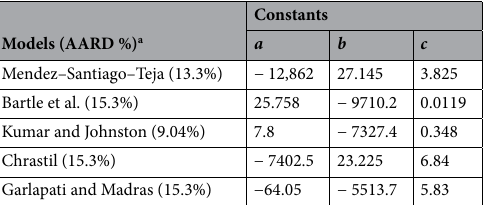
Table 3. Fitting parameters and AARD % of the examined correlations. a AARD % = 100 × ∑ ((y calc − y exp )/y exp ).